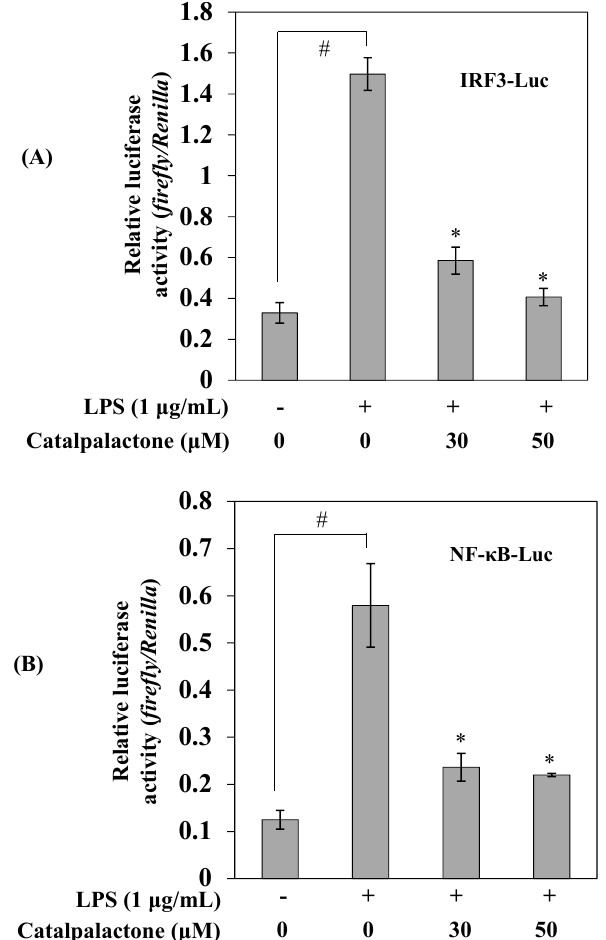
Figure 5. Effects of catalpalactone on interferon regulatory factor 3 (IRF3) ( A ) and nuclear factor- κ B (NF- κ B) ( B ) activation in LPS-stimulated RAW264.7 cells. RAW264.7 cells were transfected with pIRF3-luc and pNF- κ B-luc reporter vectors. The pRL-TK vector was used as an internal control. The cells were pretreated with various concentrations of catalpalactone (30 and 50 µ M) for 2 h and then stimulated with or without LPS (1 µ g/mL) for 24 h. Luciferase activity was measured using a Dual-luciferase Reporter Assay System. Data are presented as the mean ± SD ( n = 3). # p < 0.05 vs. control cells, * p < 0.05 vs. LPS-treated cells.